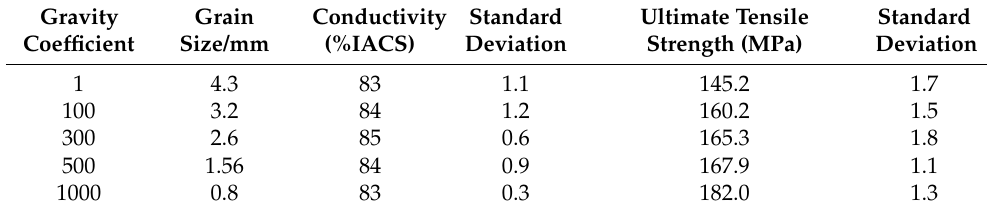
Figure 8. The stress–strain curves of Cu-0.5Sn alloys under different gravity coefficients. Table 2. The experimental results under different gravity coefficients.